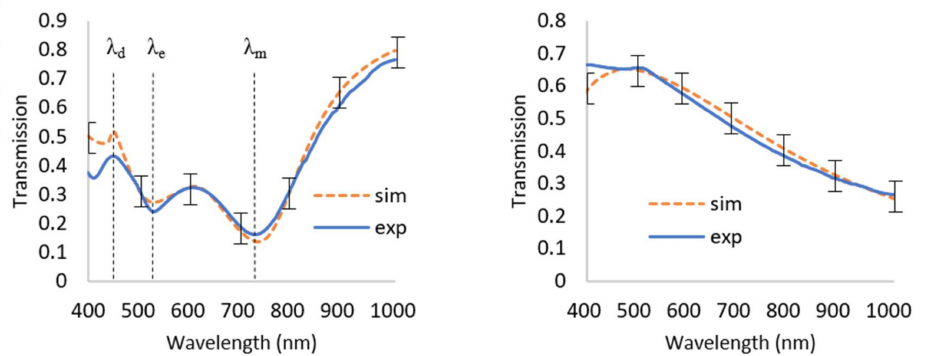
Figure 5. Normal incidence transmission for TM ( Left ) and TE ( Right ) polarizations. Note that only ε y is responsible for TE spectra, while TM spectra depends on ε x , ε z , and µ y . With TM polarization, λ d , λ e , and λ m correspond to the Wood’s anomaly (diffraction threshold), electric resonance, and magnetic resonance, respectively. Data is matched by providing incremental adjustments to the parameters of each dielectric function. Note that the set of parameters providing agreement here must also provide satisfactory matching for the spectral-angular data. Error bars in simulated spectra reflect ± 5%